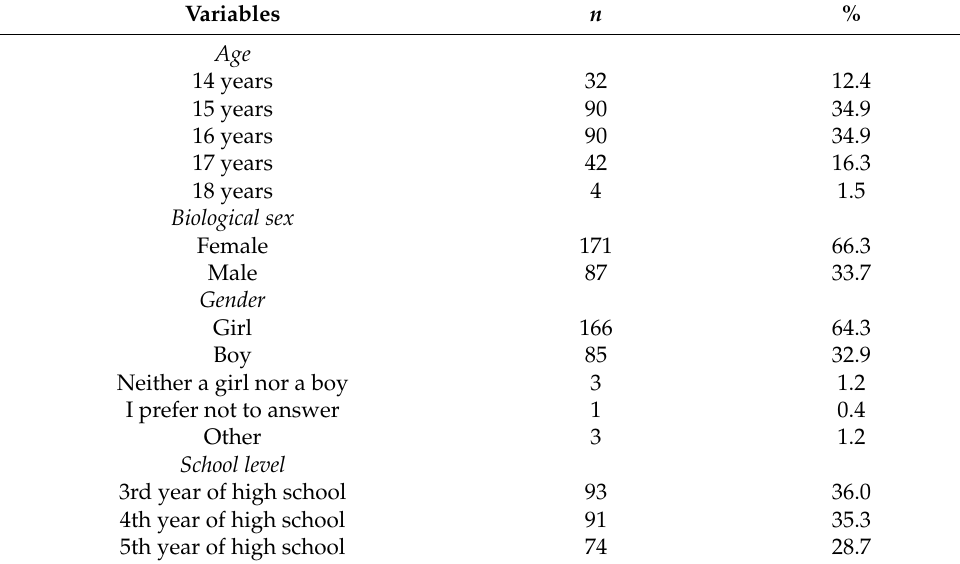
Table 1. Sociodemographic characteristics of participants ( n =